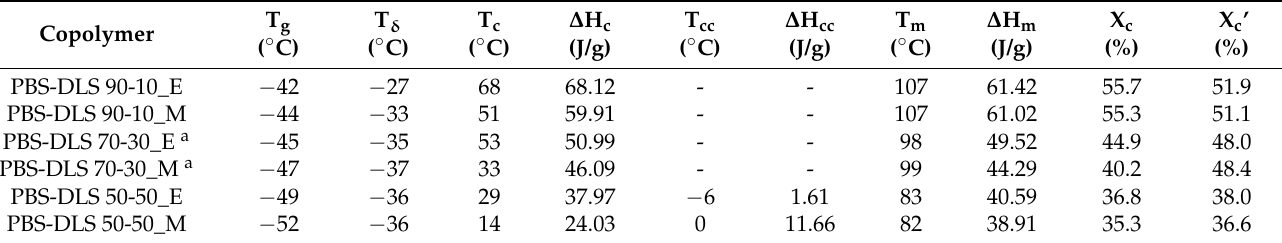
Table 3. DSC results for PBS-DLS copolymer